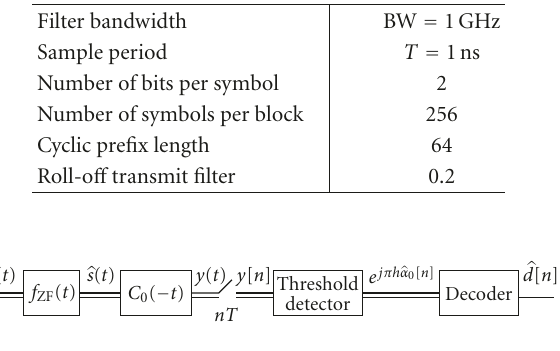
Figure 9: Linear GMSK receiver using the Laurent